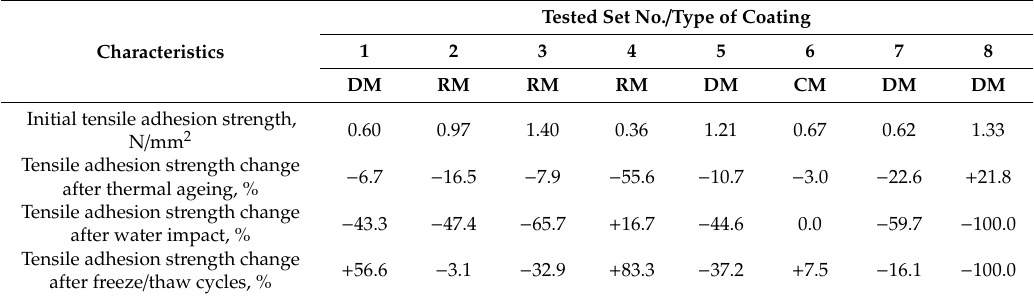
Table 4. Comparison of percent change in the sets’ adhesion strength after exposure to ageing factors versus the initial value.